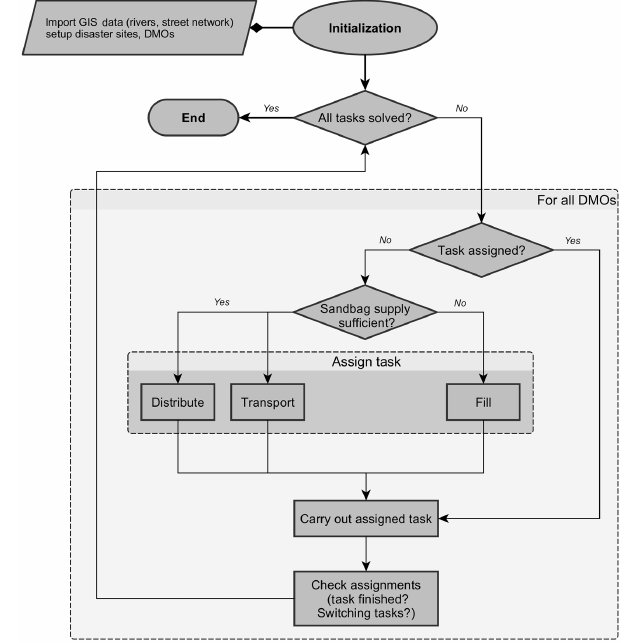
Figure 2. Model flow chart showing the general temporal sequence of processes. Processes in the dashed box are carried out in each time step for each DMO (disaster management organization)